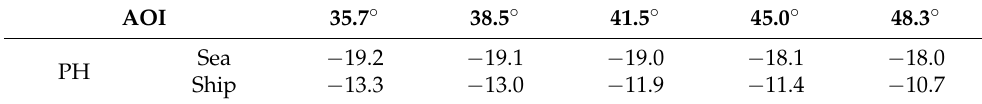
Table 5. Mean PH values (in dB) evaluated over both sea and ship ROIs at the five AOIs.